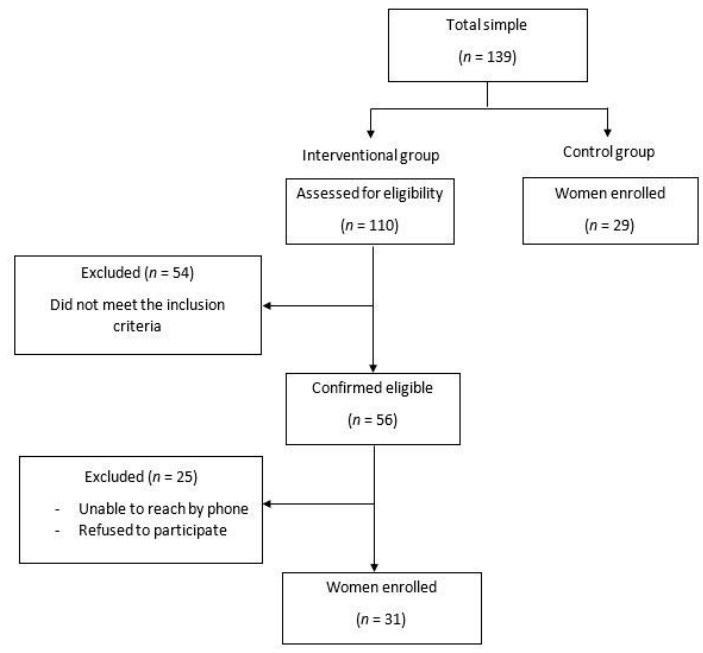
Figure 1. Study Figure 1. Study design.